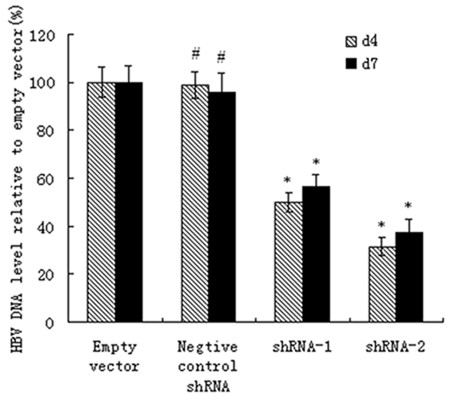
Serum HBV DNA levels by HBV shRNAs in mice. The levels of HBV DNA were significantly reduced by treatment with pWPT-HBV-shRNA lentivirus. The inhibition of HBV DNA was specific (error bars indicate standard errors). The mean value of empty control was defined as 100%. * P < 0.05 vs. the empty vector group. # P > 0.05 vs. the empty vector group.